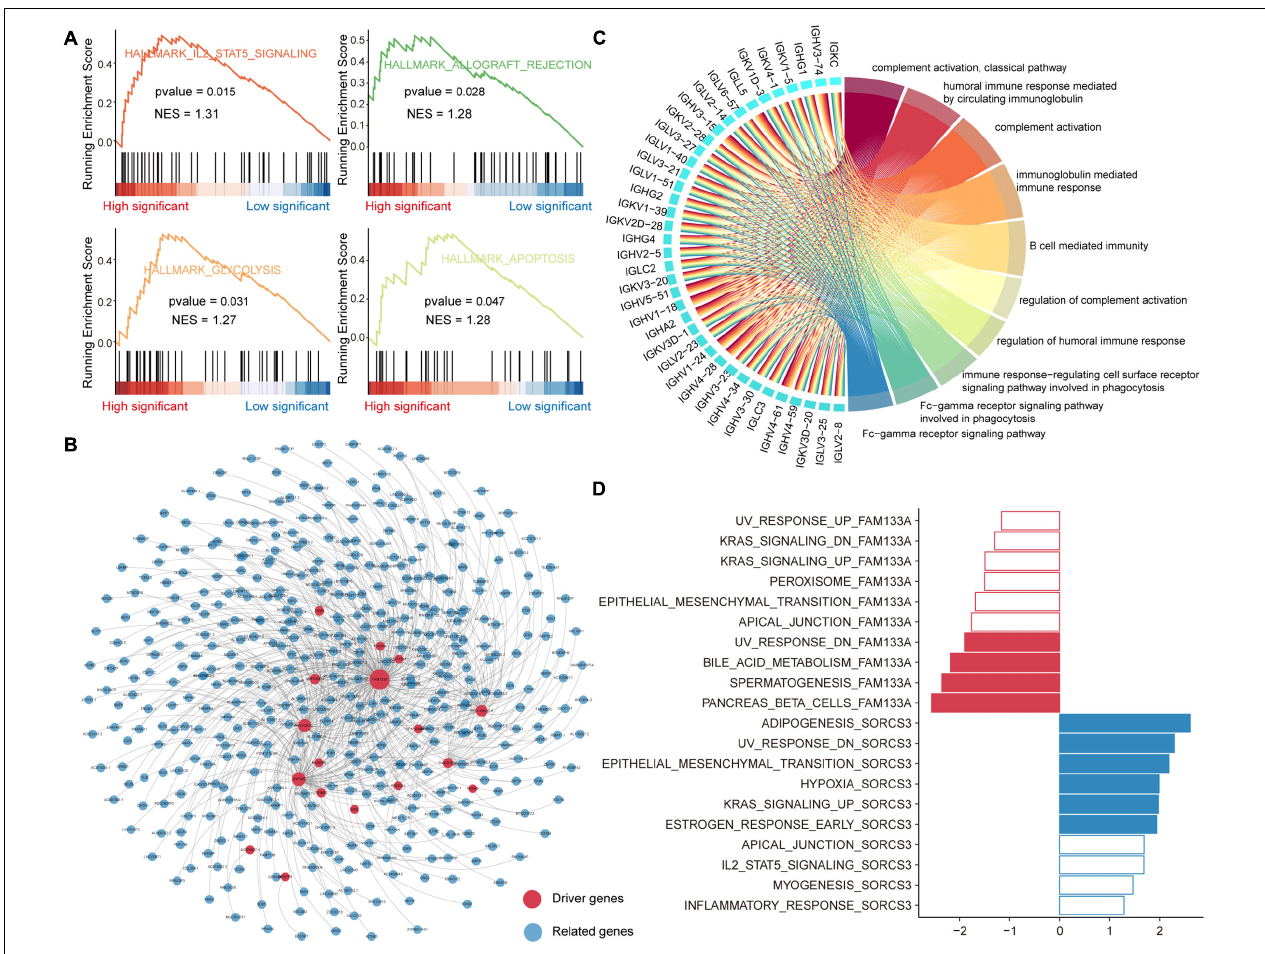
FIGURE 3 | Functional enrichment analysis of driving related genes. (A) The GSEA analysis of mutant genes, which explain somatic mutations in the genome of PAAD patients. (B) Co-expression network of driver genes and their significantly related genes. The size of the node is related to the degree. (C) The top 10 GO items that are enriched by genes significantly related to driver genes. This network shows the interaction between genes and GO items. (D) Top 10 hallmark pathways enriched in genes related to driver gene FAM133A or SORCS3. significantly enriched pathways with GSEA p -values < 0.05 are highlighted in red (FAM133A) or blue